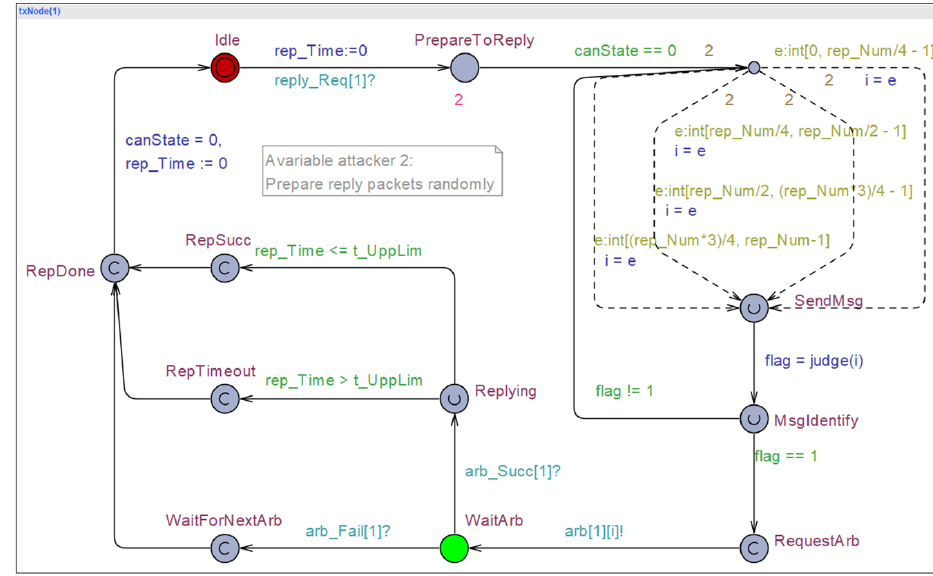
Figure 8. TA of the slave node in the CAN bus: txNode(i). In order to simulate real transmission, we set different preparation times for different nodes in order to achieve the random timing of the transmission. When the bus is free in the arbitration phase, the node sends an arbitration request arb[i][e]! and then reaches the location WaitArb. During the arbitration, the nodes with lower priority are eliminated